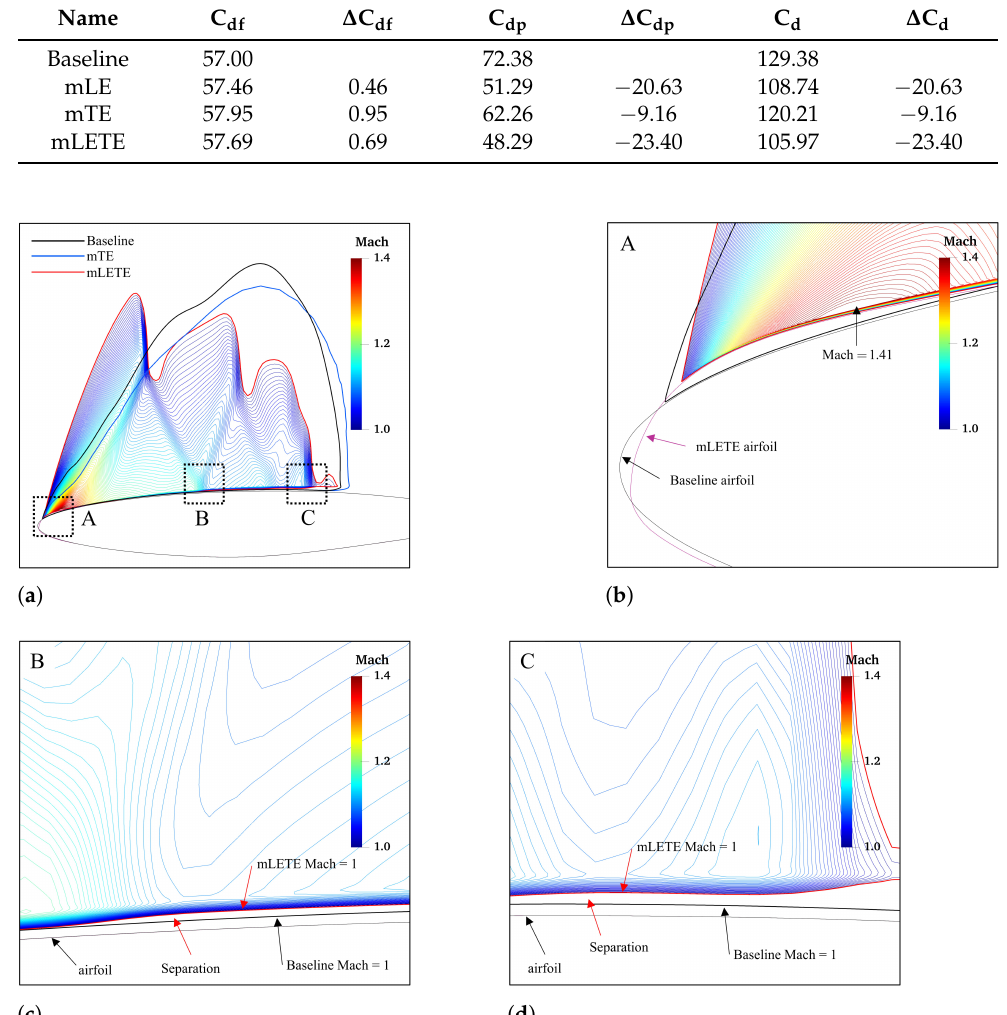
Figure 14. Mach contour of baseline and optimized airfoils; please notice the lambda shock in the supersonic region and separation points. ( a ) Mach flow. ( b ) Leading edge. ( c ) Separation point 1. ( d ) Separation point